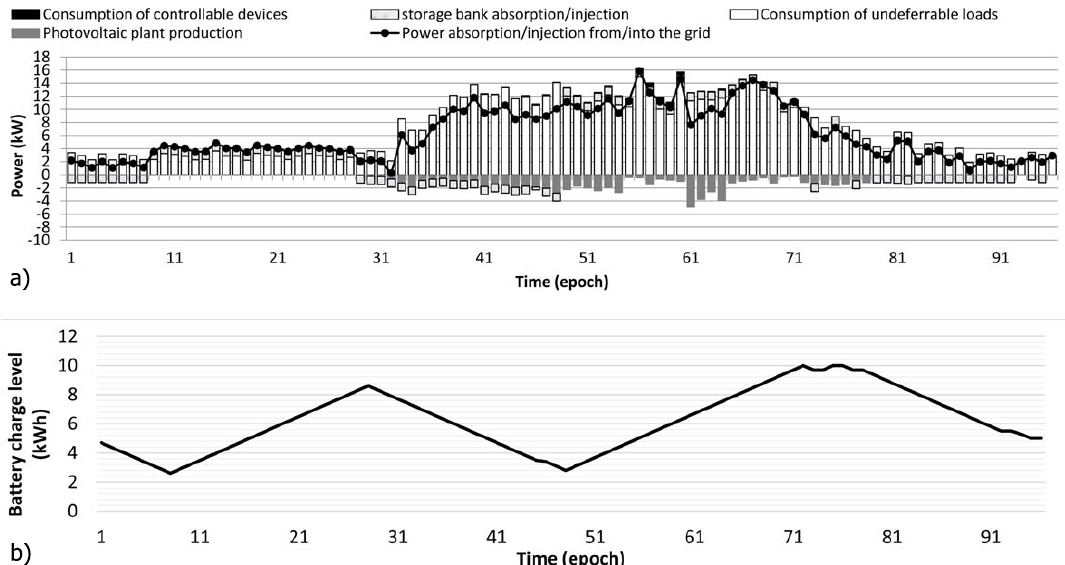
Figure 7. EMS schedule of daily energy exchanges with the electricity grid and storage bank charge/discharge periods ( a ) and storage bank charge level ( b ) during a partially-cloudy working day. Positive (negative) values indicate energy purchases (sells), energy consumption (production) and battery charges